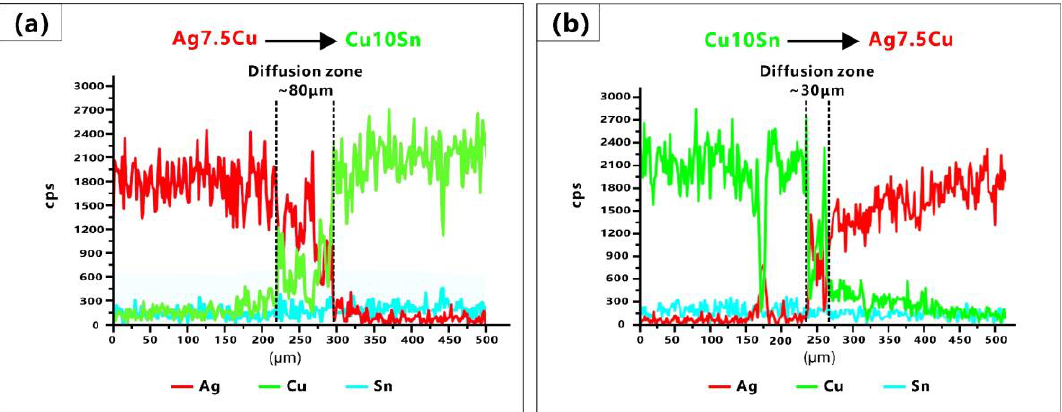
Figure 7. EDS line scan results along the scan path 1 ( a ) and 2 ( b ) presented in Figures 5a and 6a, respectively.